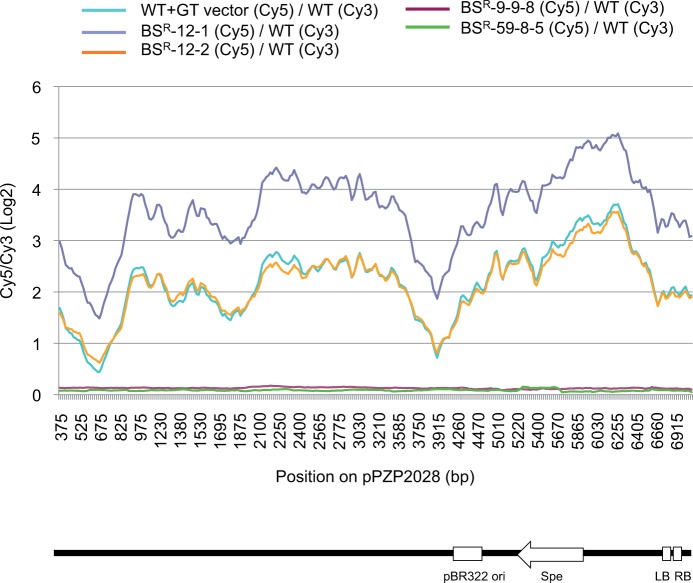
Array CGH ratio plots for the forward strand of binary vector pPZP2028. The log2 ratios of Cy5/Cy3 using a moving average of 20 adjacent probes (1.2 kb) were plotted against the cumulative kilobase pairs position. Locations of pBR322 ori, Spectinomycin resistance gene, LB and RB sequence existing on pPZP2028 are shown below the graph.